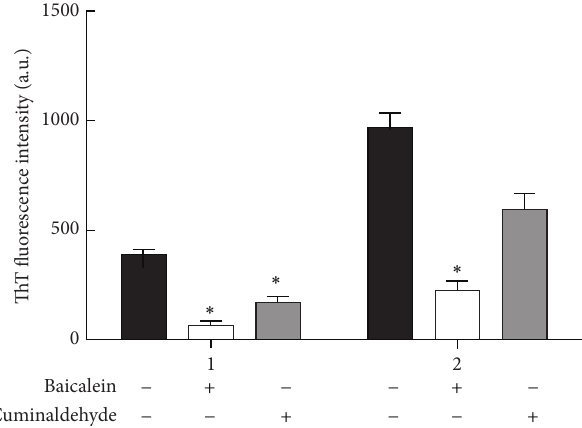
Figure 4: Effect of M. communis on the inhibitors of 𝛼 -Syn fibrilla- tion.Therateof 𝛼 -Synfibrillationwith400 𝜇 Mbaicalein(white)and cuminaldehyde (gray) was monitored by ThT fluorescence. There is no M. communis in series (1) and there is 1% (v/v) of M. communis in series (2). The black columns represent 𝛼 -Syn with no inhibitors. Each value represents the mean ± SD ( 𝑛 = 3 ). ∗ 𝑃 < 0.05 (one-way ANOVA) indicated the samples are significantly different from the